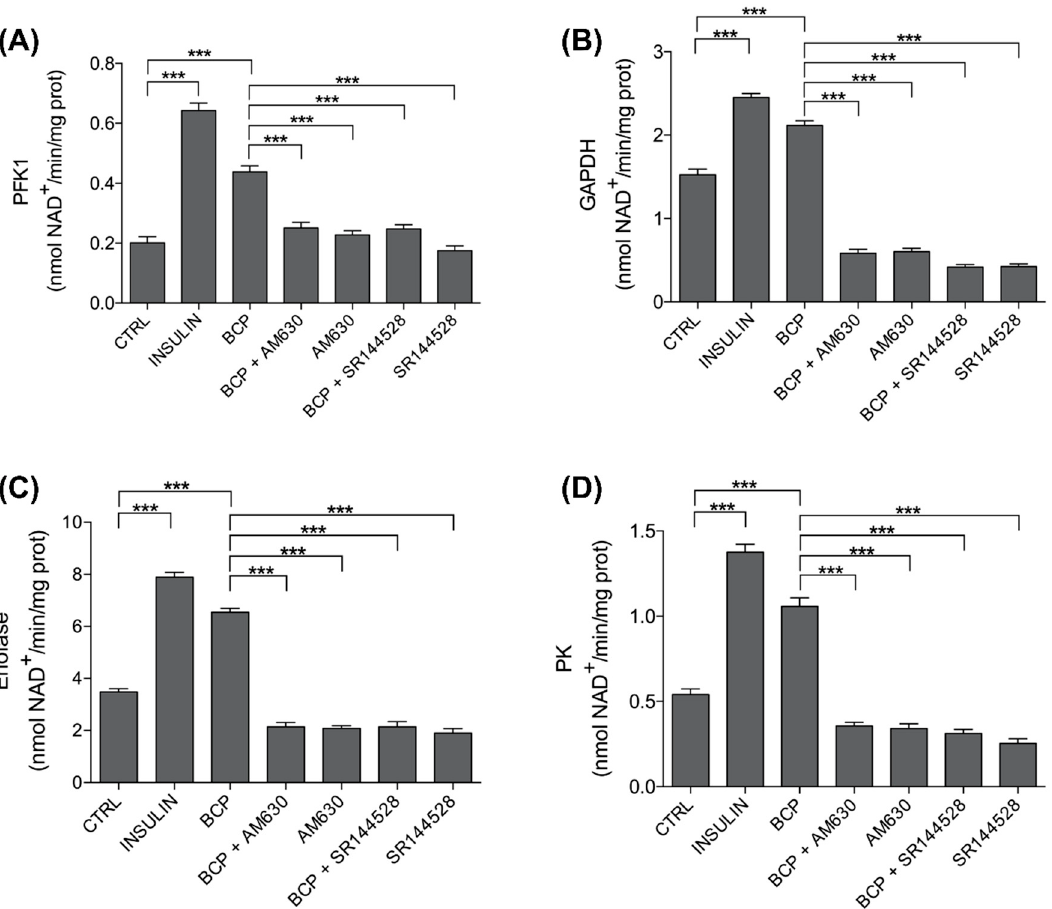
Figure 4. Effects of trans - β -carophyllene on glycolysis. C2C12 cells were left untreated (CTRL) or treated with insulin (25 nM for 30 min; INS), BCP (10 nM for 30 min), AM630 (5 µ M for 2 h) or SR144528 (5 µ M for 2 h), alone or in combination with 10 nM BCP, added in the last 30 min. The enzymatic activities of ( A ) phospho-fructokinase 1 (PFK1), ( B ) glyceraldehyde 3-phosphate dehydrogenase (GAPDH), ( C ) enolase, and ( D ) pyruvate kinase (PK) were measured spectrophotometrically in the whole cell lysates in triplicate. Data are expressed as means ± SEM (n = 3). *** p < 0.001. Table 1. Trans- β -Caryophyllene (BCP) effects on glycolytic pathway.